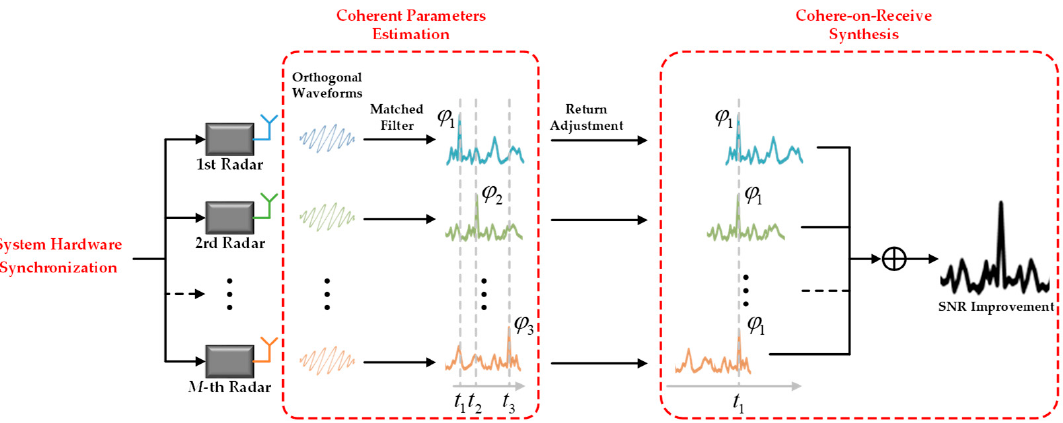
Figure 1. The workflow diagram of CoRS in DCAR.